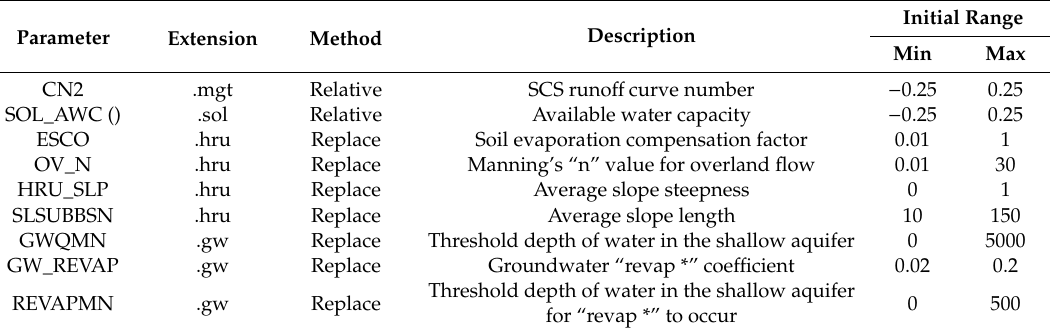
Table 2. Parameters used for the calibration and their initial ranges.